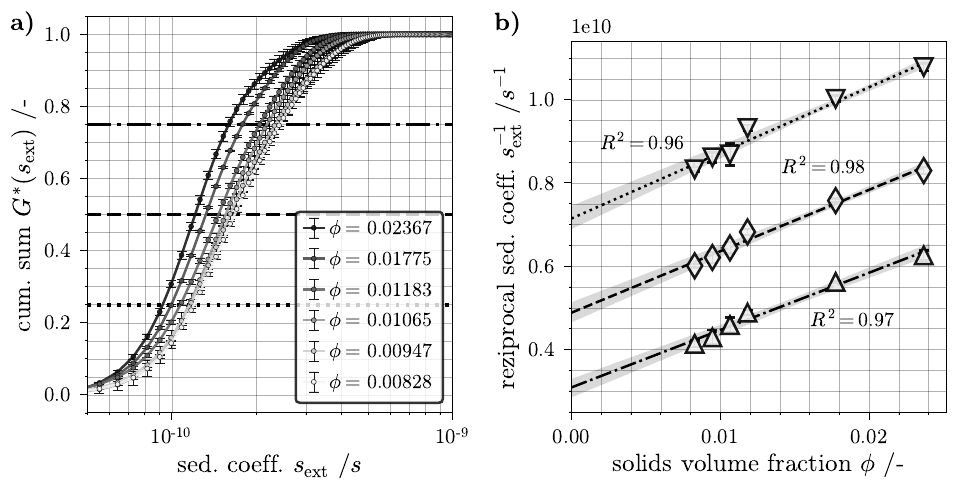
Figure 6. Cumulative sum distribution G ∗ ( s ext ) derived by least-squares boundary modeling (LSBM) code based on analytical centrifuge (AC) extinction profiles ( a ). Reciprocal ext. weighted sedimen- tation coefficient s − 1 , s − 1 and s − 1 plotted against φ of the analyzed silicon dioxide (SiO 2 ) 25,ext 50,ext 75,ext suspension; dotted, dashed and dash-dotted lines indicate a linear least squares fit (Equation (31)) with an associated coefficient of determination R 2 ( b ). Note that the lines indicate the connection between the data extracted from ( a ) and plotted in ( b